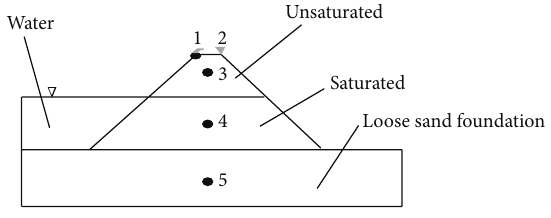
Figure 3: Key points (1–5) in models.